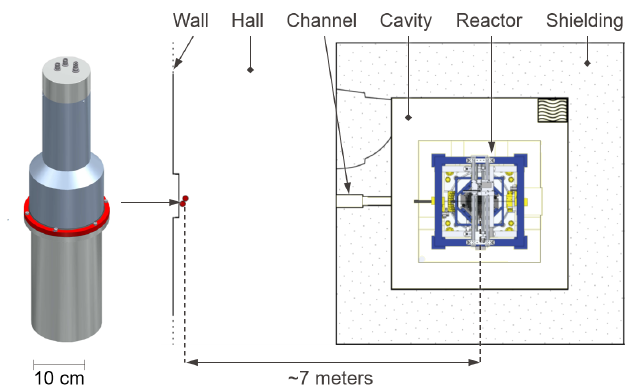
Fig. 5. CAD model of a BGO gamma scintillator (left), and positioning at about seven meters with respect to the reactor core center with a direct line of sight.